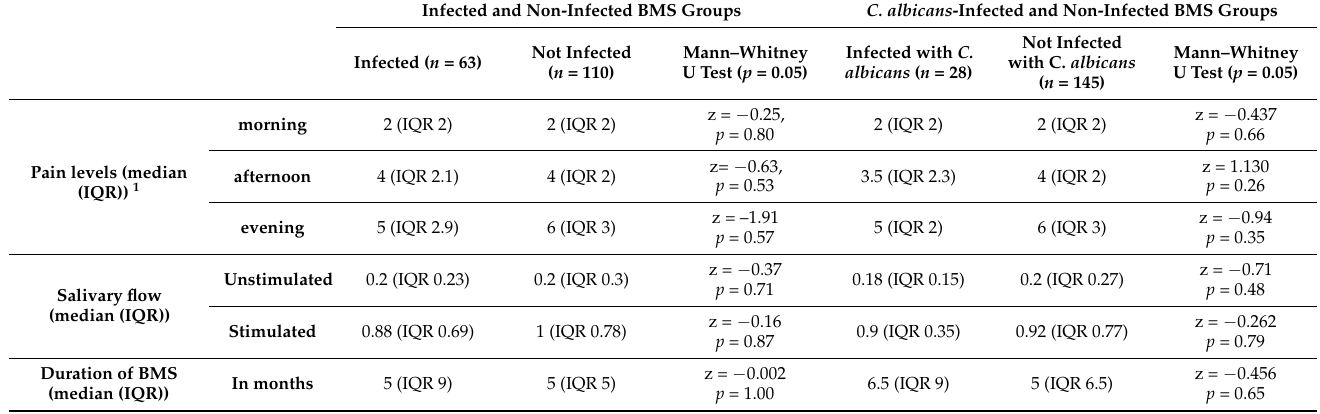
Table 3. Differences between infected and non-infected BMS groups (overall infected patients